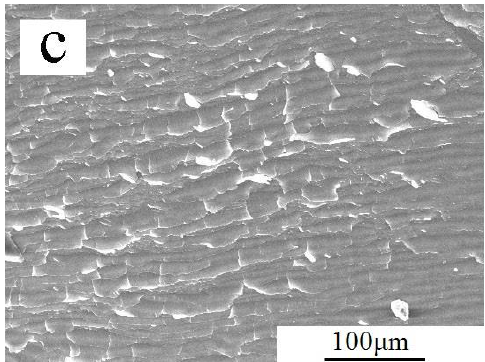
Figure 9. Morphologies of tensile fracture with different tool offset: ( a ) T2,( b ) T5,( c ) T7.